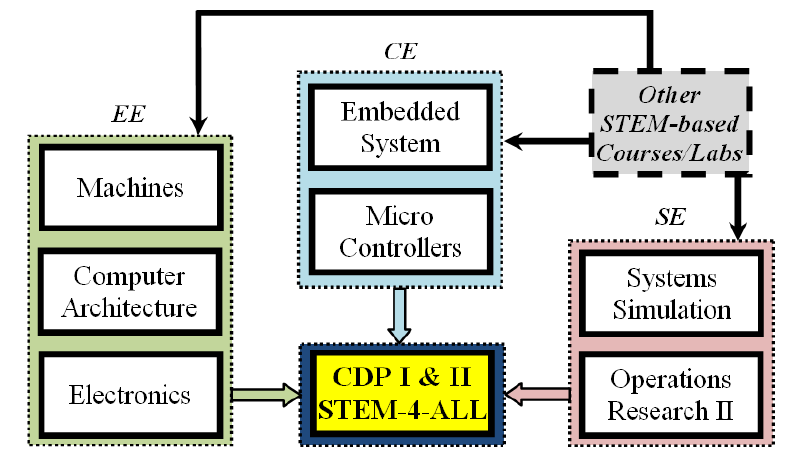
Fig. 4. CDPs and their